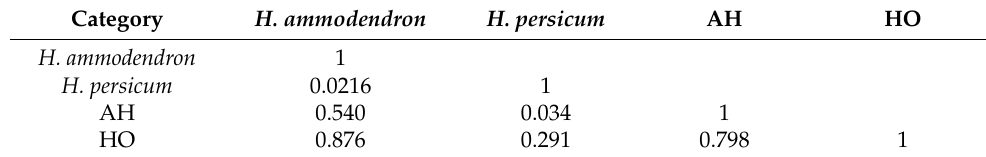
Table 3. The niche range overlap values of hosts and two strategies; threshold value is 0.65.